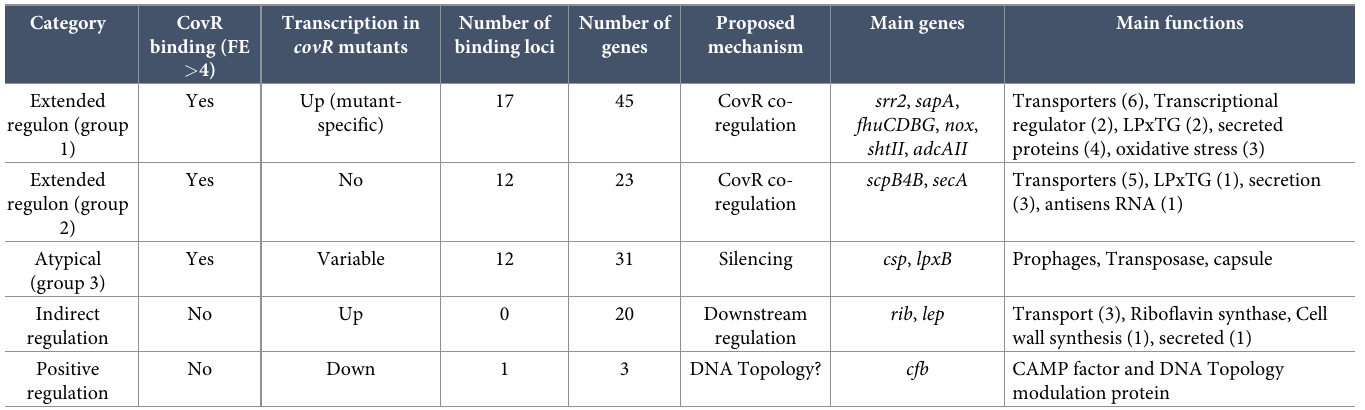
Table 2. The extended CovR signaling pathway in